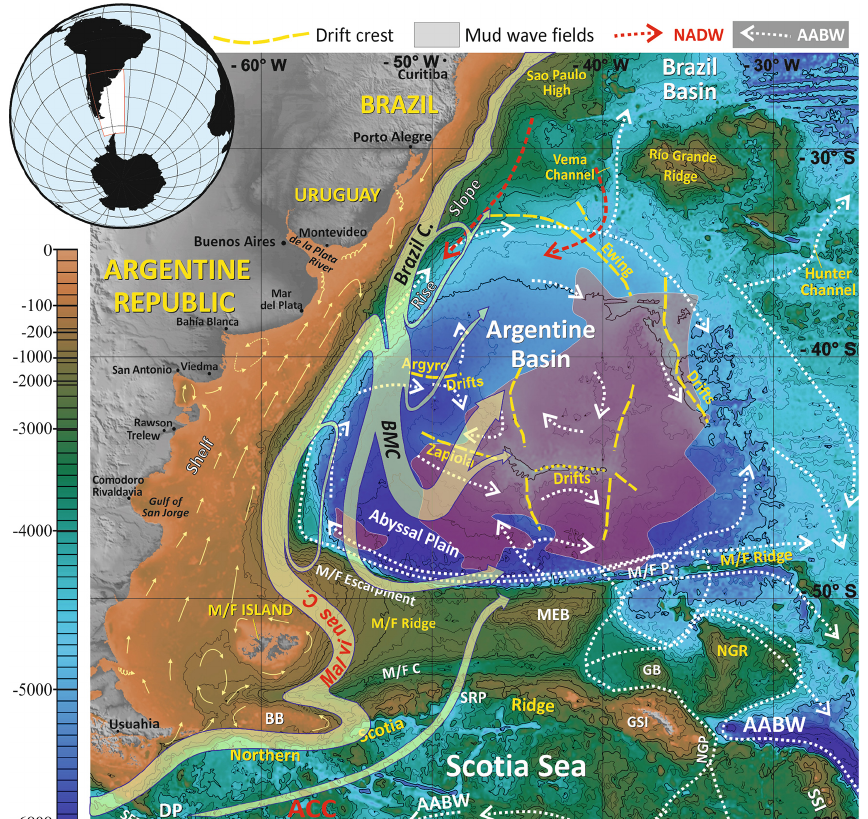
Figure 2. Location of Argentine Basin with regional bathymetric map and general circulation of surface and deep-water masses indi- cated (after Hernández-Molina et al., 2010). Legend for the physiographic reference points, in alphabetical order: BB: Burdwood